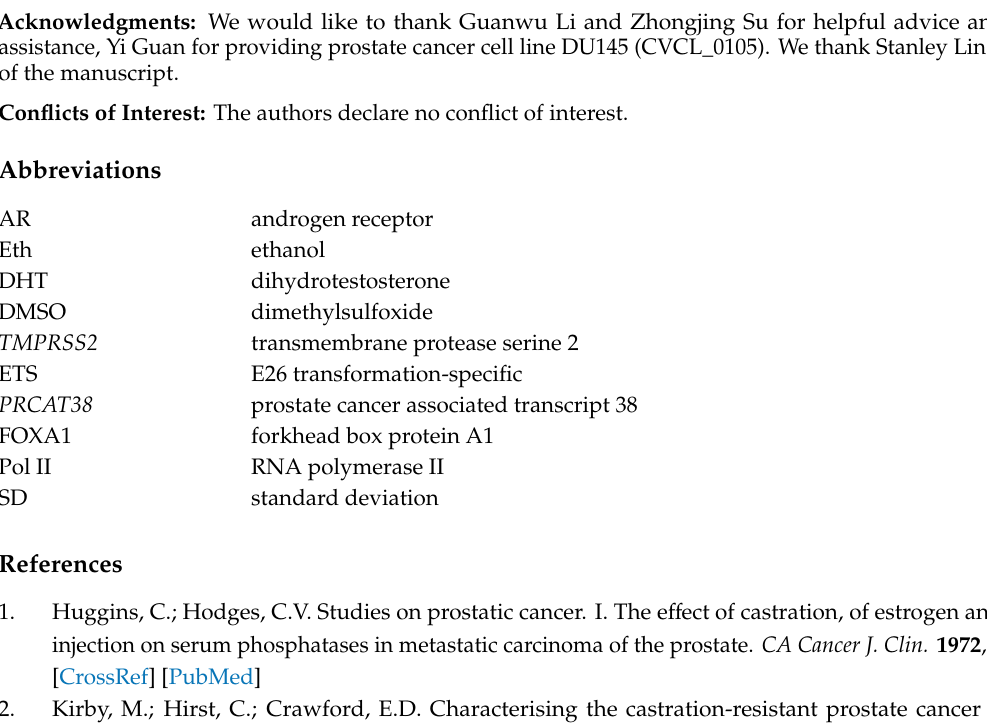
Figure S1: PRCAT38 is androgen responsive and specifically expressed in prostate cancer samples, Figure S2: AR binds to enhancers between TMPRSS2 and PRCAT38, recruiting Pol II and H3K27ac to activate enhancers in VCaP cells, Figure S3: AR, Pol II, H3K4me1 and H3K27ac enrichment at the PRCAT38 promoter, Figure S4: Knockout of enhancer E1 or E2 downregulates transcription of TMPRSS2 and PRCAT38, Figure S5: Knockdown of FOXA1 inhibits PRCAT38 transcription, Figure S6: p300 inhibition does not a ff ect the total amount of H3K27ac or eRNA transcription from enhancer E1 or E2, Figure S7: Schematic for simultaneous regulation of TMPRSS2 and PRCAT38 by enhancer E1 and E2, Table S1: Primer sequences for quantitative PCR, Table S2: Primer sequences for ChIP PCR, Table S3: The sequences of siRNA and ASO, Table S4: Primer sequences for molecular cloning, Table S5: Primer sequences for 3C assays, Table S6: Transcription factors predicted by TRAP web tools, Table S7: sgRNA sequences and primer sequences for verification of enhancer